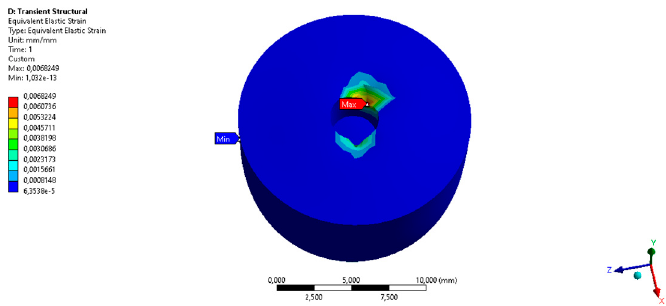
Figure 5. Thermal-Structural Analysis. Equivalent Elastic Strain 0.0068.